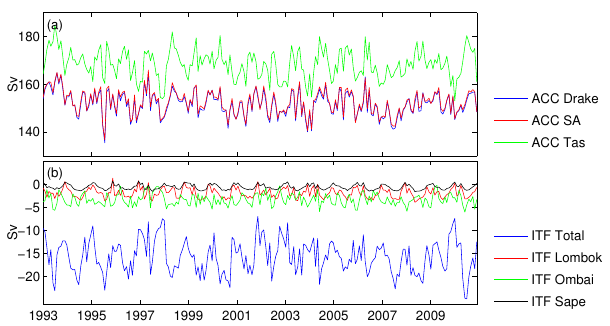
Fig. 7. Time series of the monthly averaged volume transport of the (a) ACC and (b) ITF, through various Fig. 7. Time-series of the monthly-averaged volume transport of the (a) ACC and (b) ITF, through various straits.